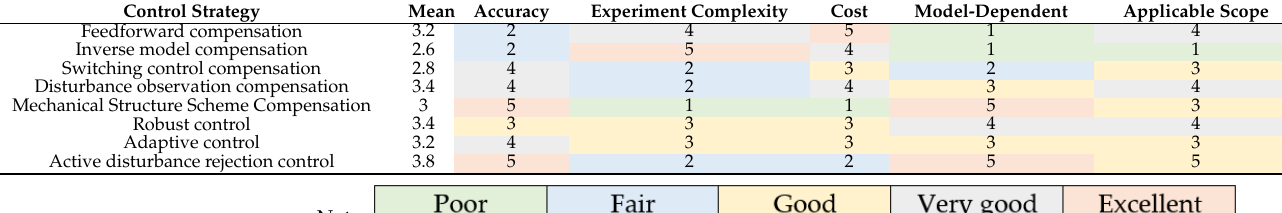
Table 2. Performance analysis table of each control strategy. Control